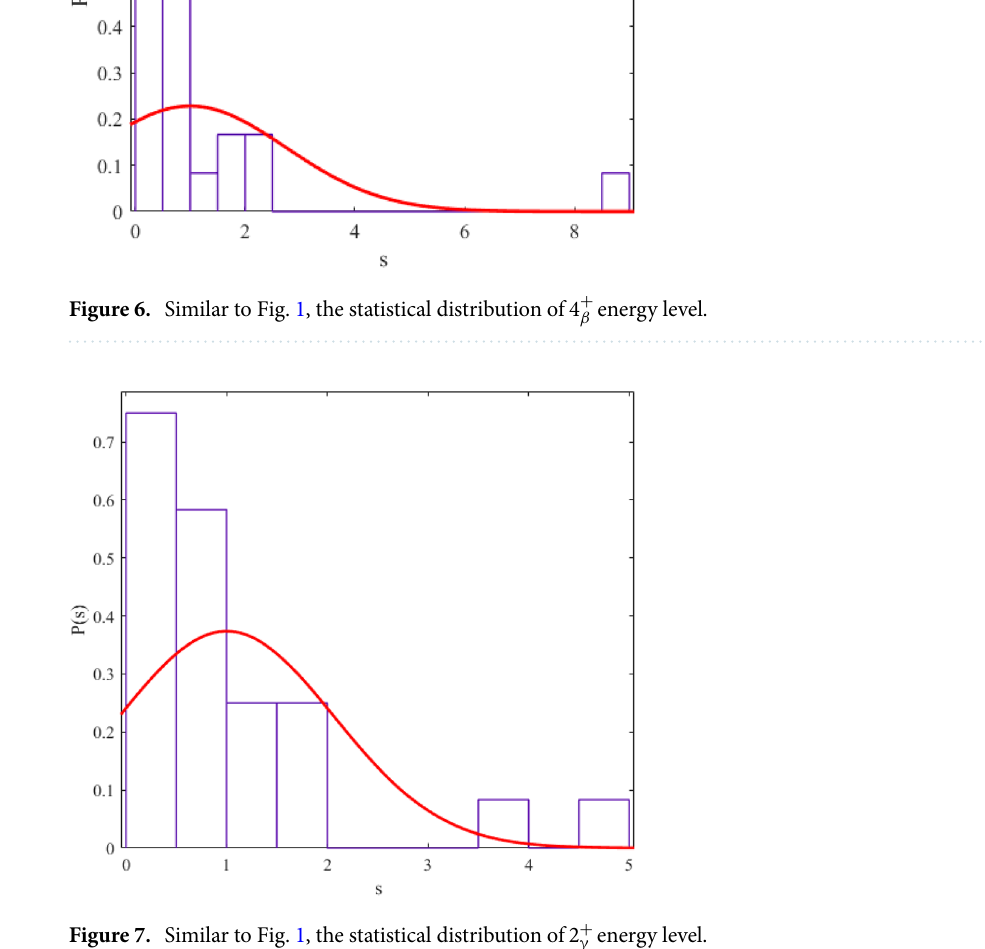
Figure 7. Similar to Fig. 1, the statistical distribution of 2 + γ energy